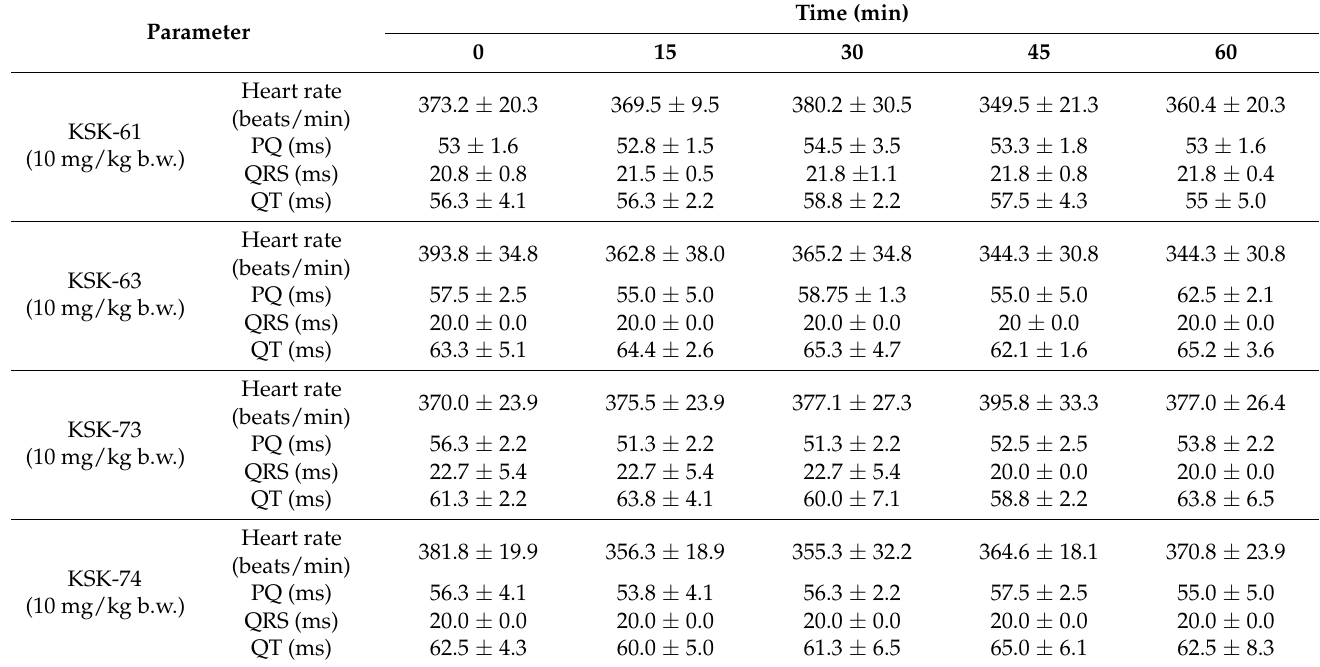
Table 3. Effects of intraperitoneal injection of compounds tested at a dose of 10 mg/kg on heart rate and ECG